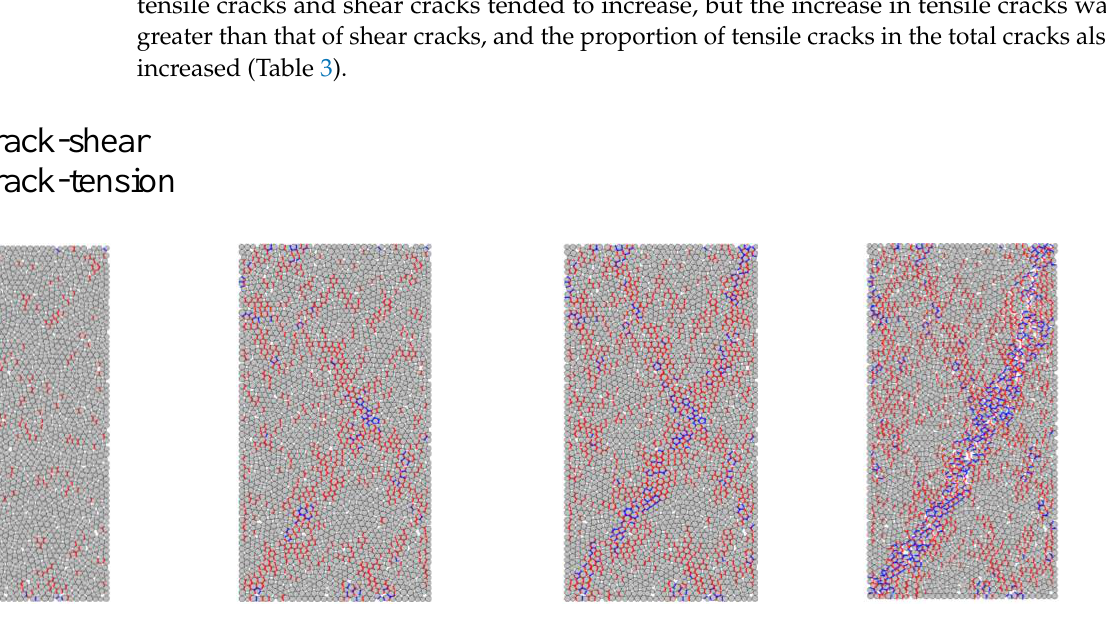
Figure 12. Crack evolution during loading. Table 3. Crack distribution at different